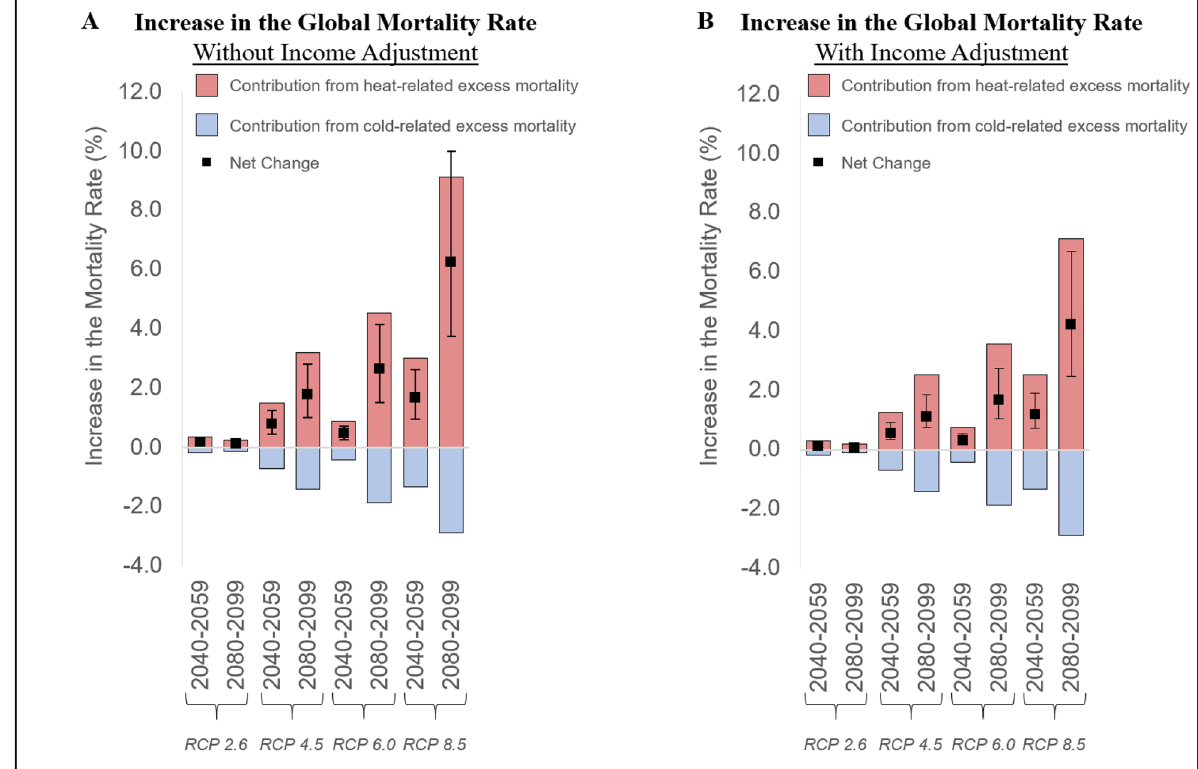
Figure 5. Increase in the global mortality rate by scenario. The graphs show the contribution of global warming towards the mortality rate through its effect on temperature related mortality, without (Panel A ) and with (Panel B ) including the estimated protective effects of higher incomes, projected using SSP3. The black error bars show 95% CIs for the net mortality impact.